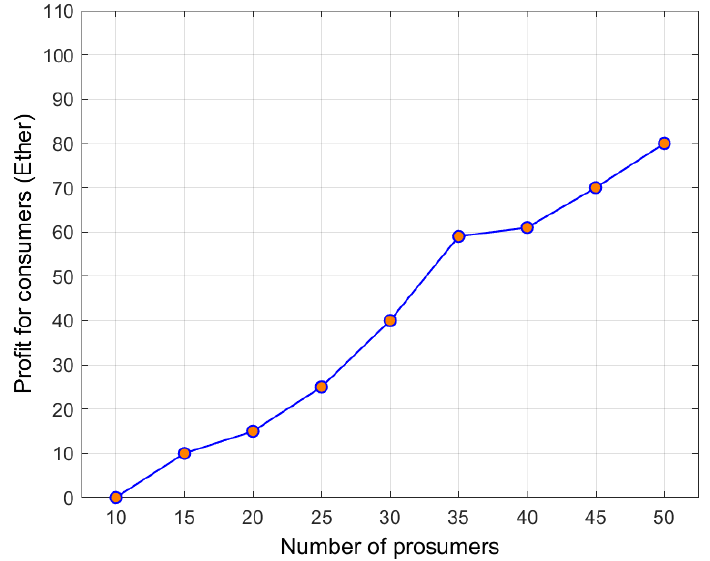
Figure 5. Profit for